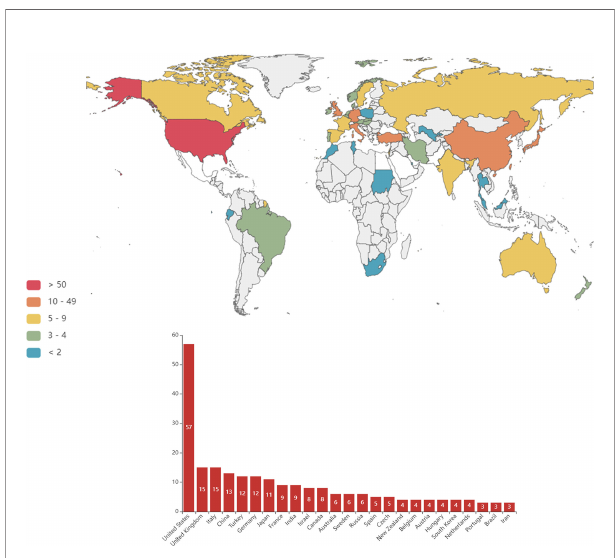
FIGURE 3 | Countries/regions with research into chronic myeloid leukemia and